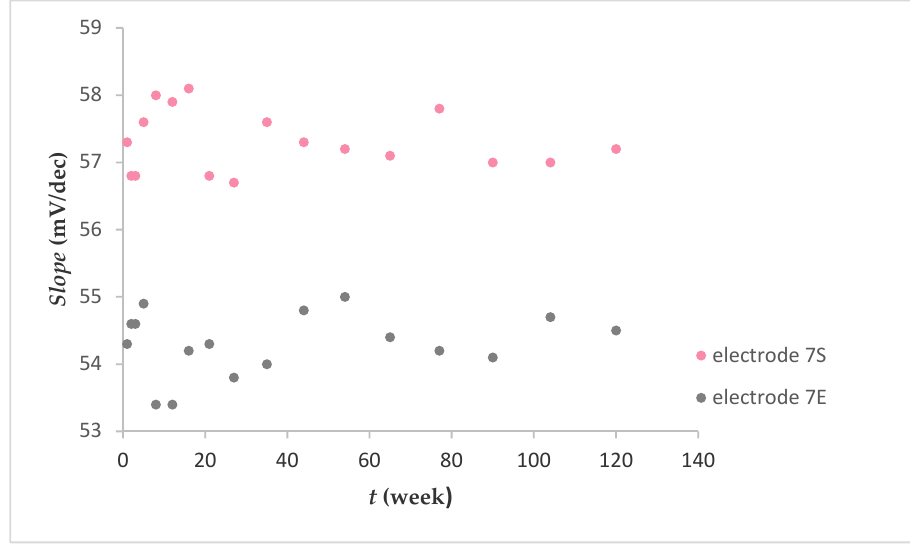
Figure 5. Fluoride response over 120 weeks (after washing Fe x O y NPs out).